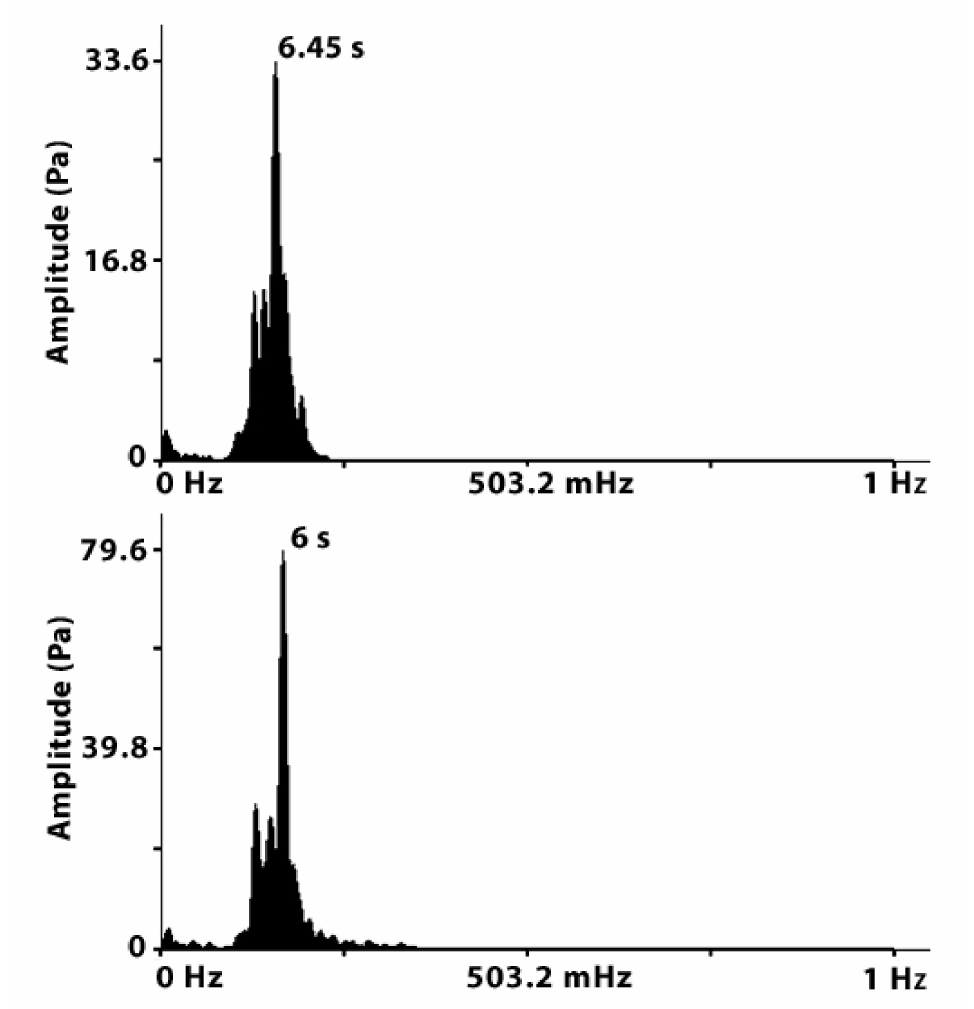
Figure 5. Spectra of synchronous fragments of the record of laser meters of hydrosphere pressure variations installed in point 1 ( top ) and point 2 ( bottom